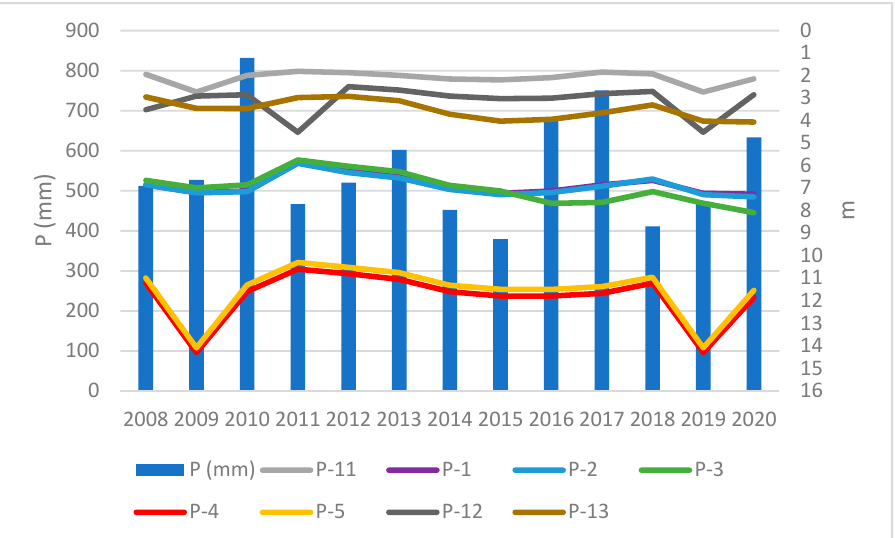
Figure 16. The lowest position of water table in piezometers in comparison with precipitation totals in the period 2008–2020.